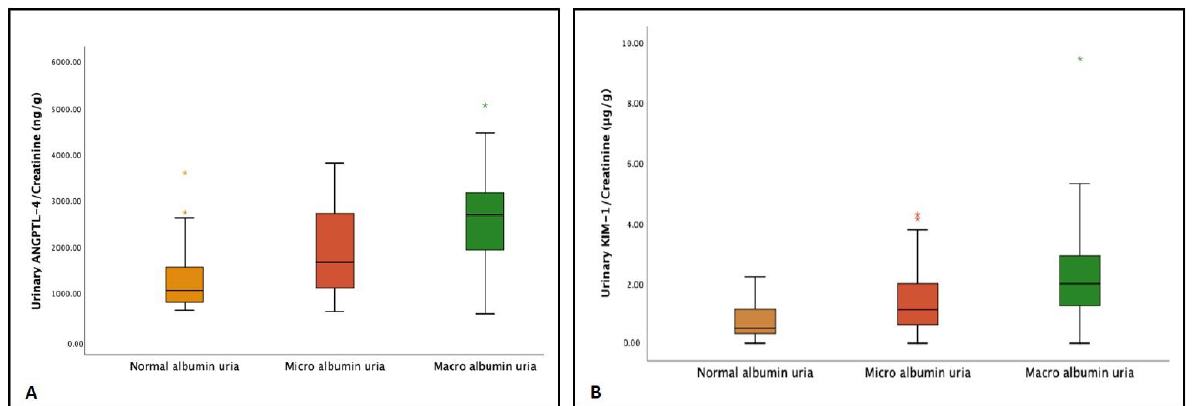
Figure 3. Urinary levels of the biomarkers ( A ) ANGPTL-4 and ( B ) KIM-1 adjusted with urinary creatinine in the patients groups classified according to urinary–creatinine ratio (UACR) levels; normoalbuminuria UACR < 30 mg/g, microalbuminuria UACR 30 to 300 mg/g, and macroalbuminuria UACR > 300 mg/g.